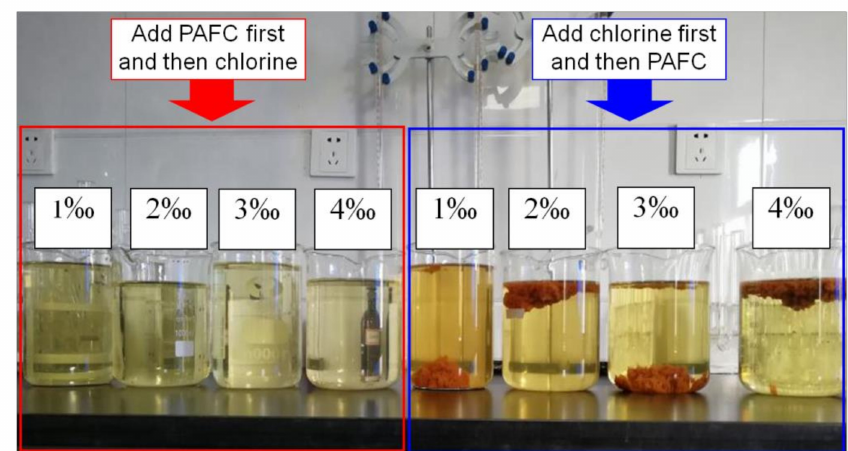
Figure 6. E ff ect diagram of di ff erent dosing sequence.